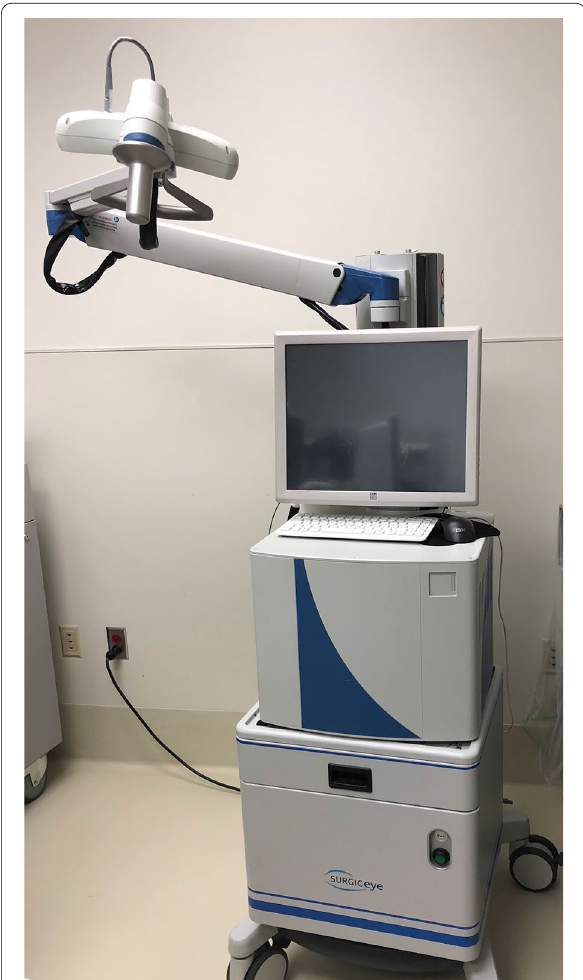
Fig. 2 The investigational camera declipse ® SPECT system. The SiPM camera is mounted in a holder behind the monitor when not in